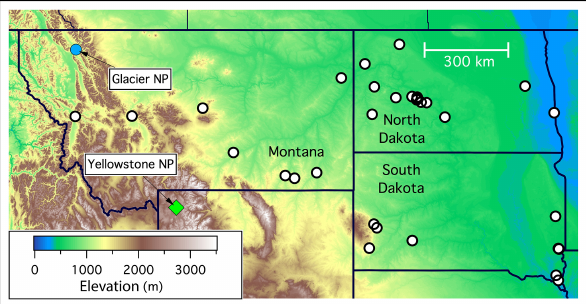
Figure 1. Topographical map of the three rural western states, with symbols indicating the locations of the monitoring sites. The two colored symbols indicate two long-term sites in national parks that are discussed in detail. Note that Yellowstone National Park is lo- cated in Wyoming but is nevertheless considered here.